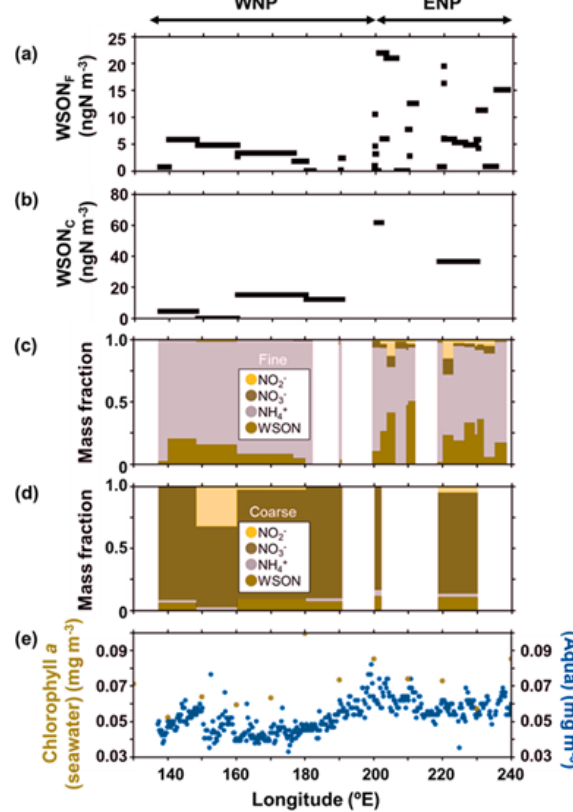
Figure 2. Longitudinal distributions of each parameter of the atmo- spheric aerosols and surface seawater along 23 ◦ N; the mass con- centrations of WSON in (a) fine particles (WSON F ) and (b) coarse particles (WSON C ); the chemical mass fractions of nitrogen species in (c) WSON F and (d) WSON C ; (e) Chl a concentrations in the surface seawater samples during the cruise (ocher) and the average Chl a concentrations from August–September 2017, as measured by MODIS-Aqua (blue). WNP and ENP denote the oceanic regions of the western North Pacific and eastern North Pacific, respectively, defined in this